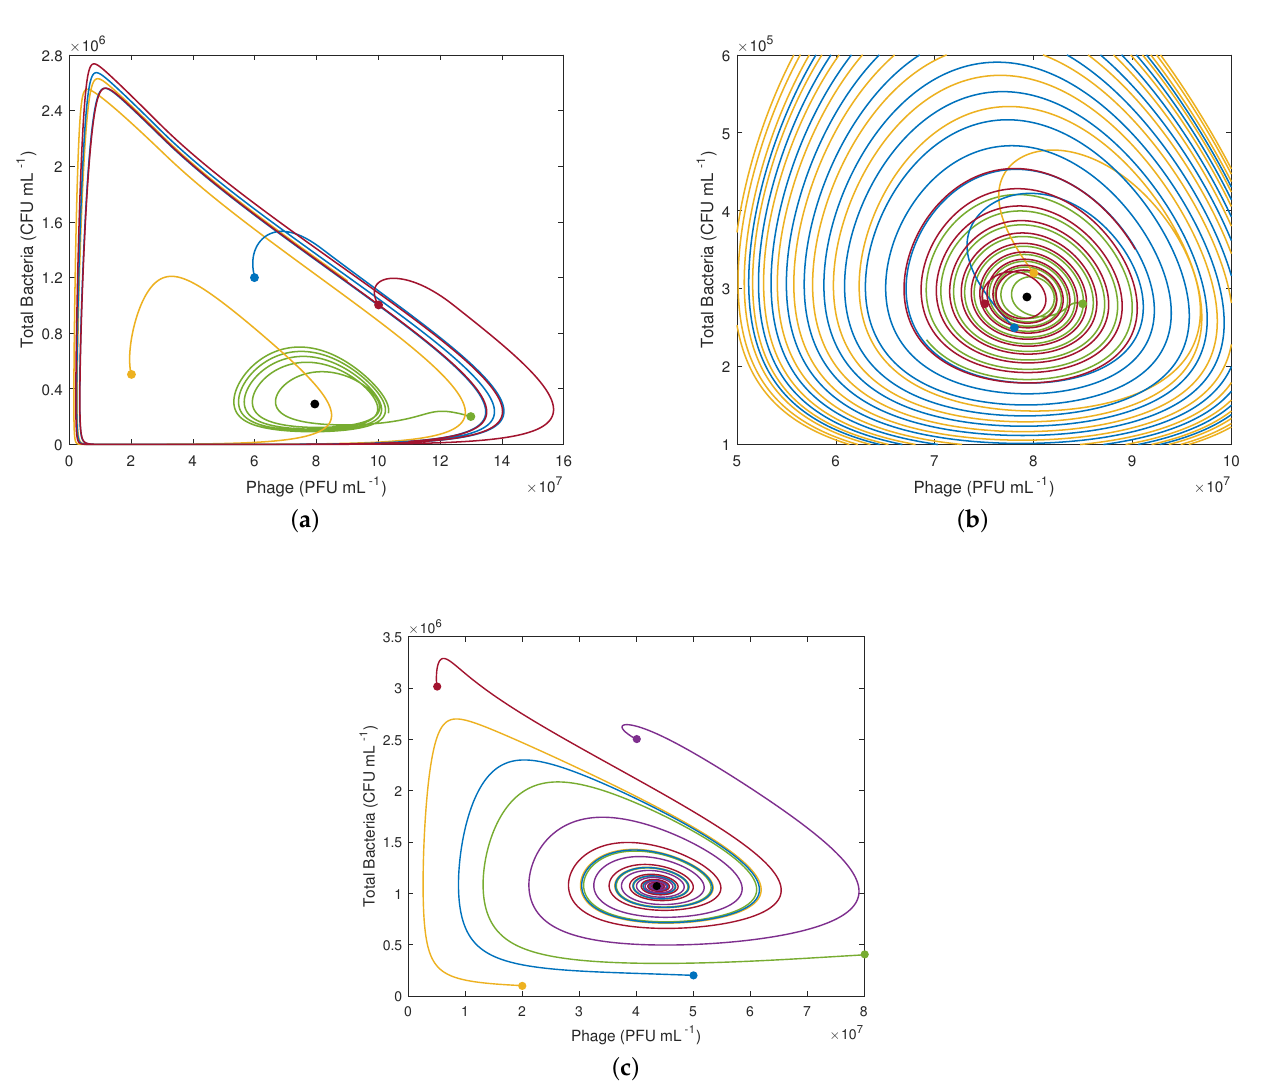
Figure 3. Phase plane. ( a , b ) D = 0.05 h − 1 . ( c ) D = 0.2 h − 1 . Black point: equilibrium point; colored points: initial